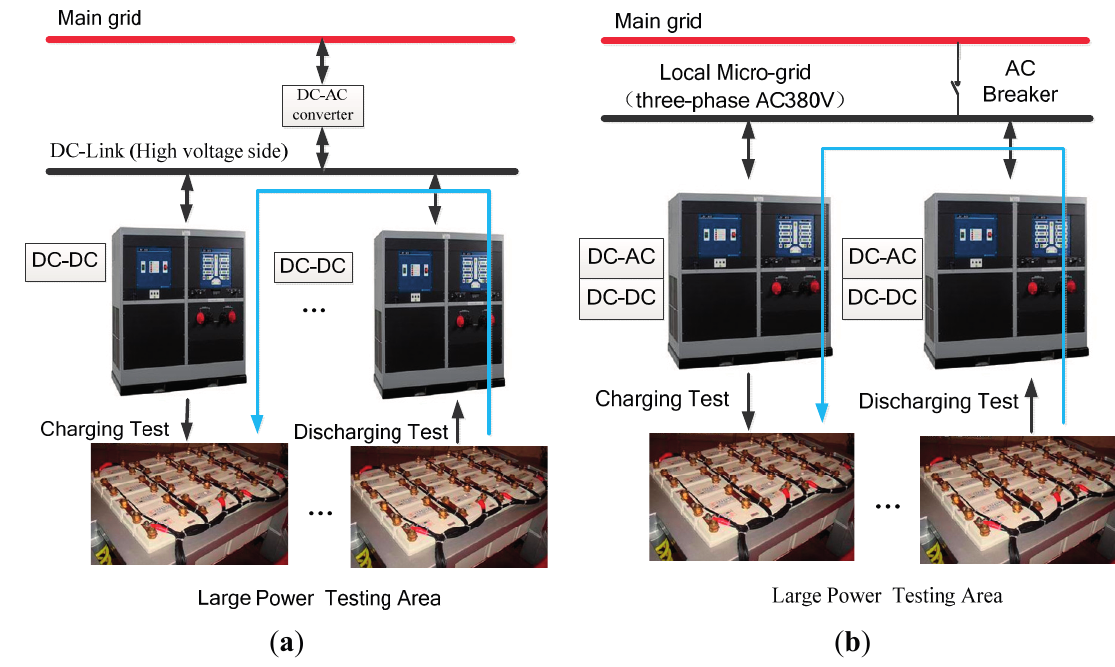
Figure 4. Energy chart between the conventional and proposed architectures. ( a ) Proposed architecture; and ( b ) Conventional